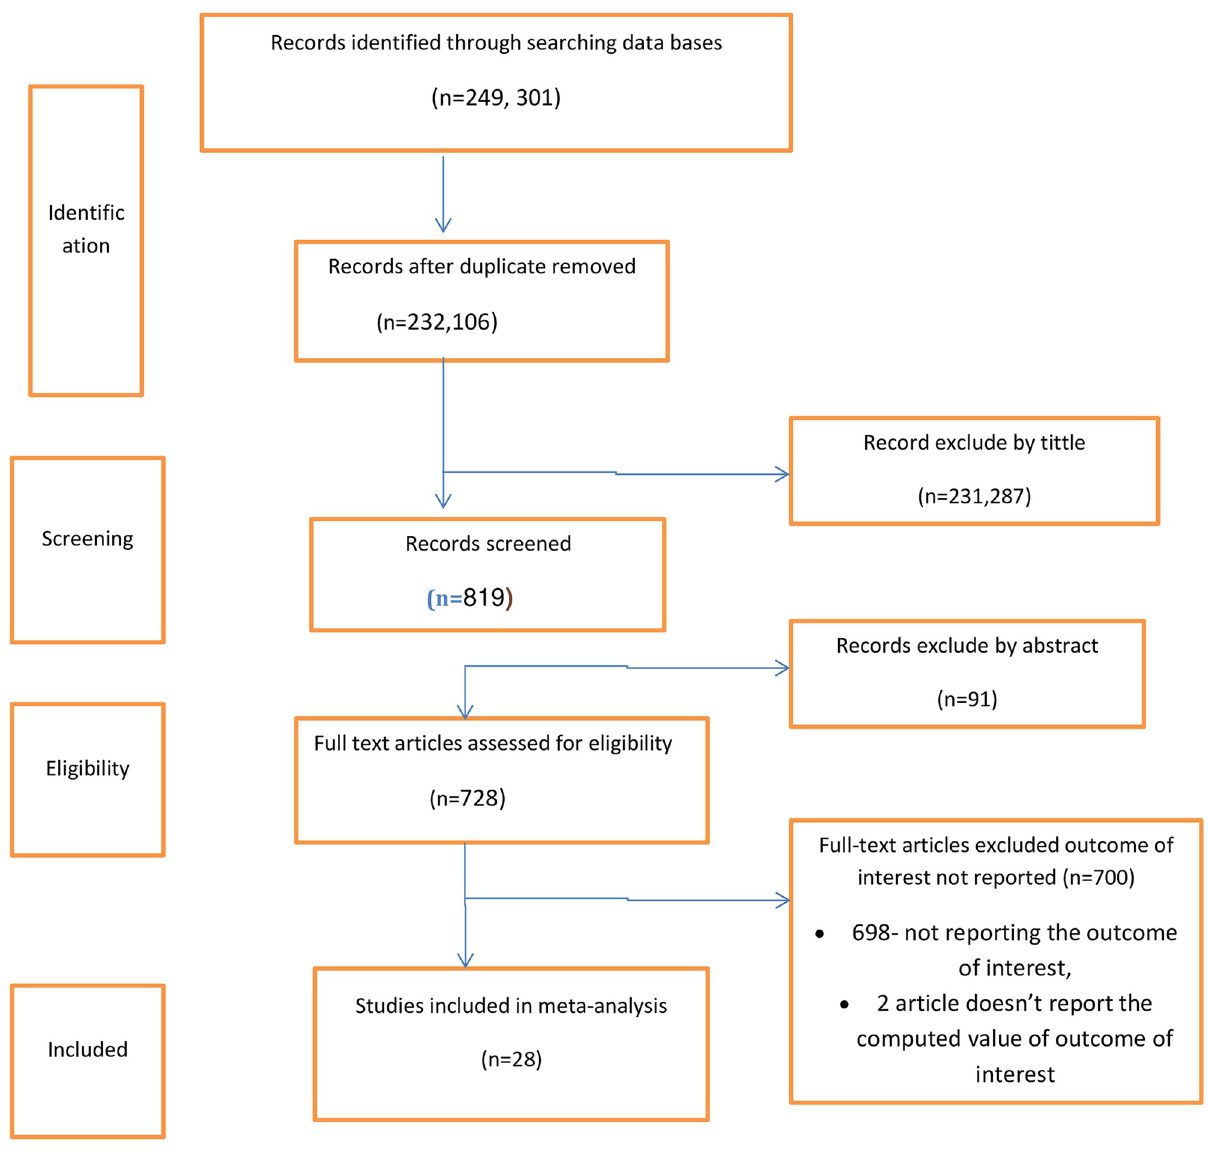
Fig 1. PRISMA flow diagram of study